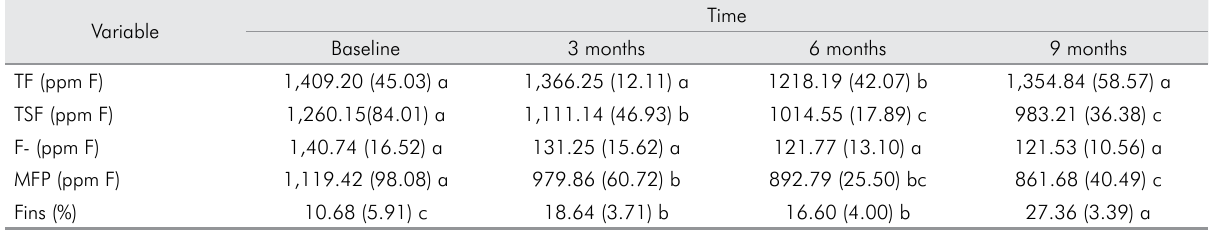
Table. Concentration (ppm F) of total fluoride, total soluble fluoride, ionic fluoride, and ionizable fluoride; and the percentage of insoluble fluoride (mean ± SD; n = 8) found in dentifrices stored in Careiro da Várzea-AM over time. Variable